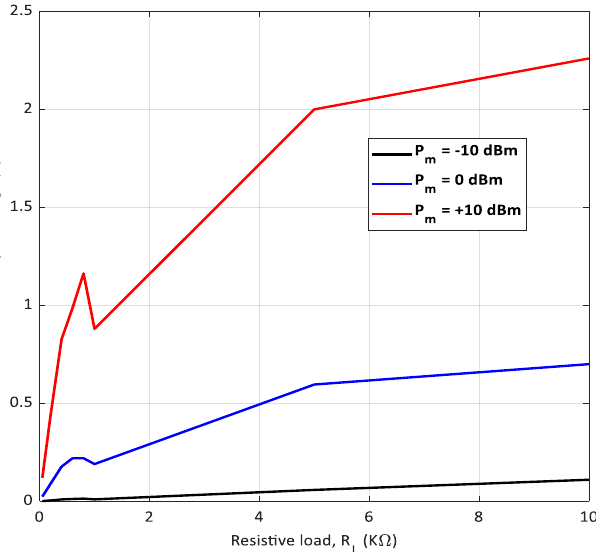
Figure 13. Output voltages at the load for different R L and P m for the rectifier circuit in Approach